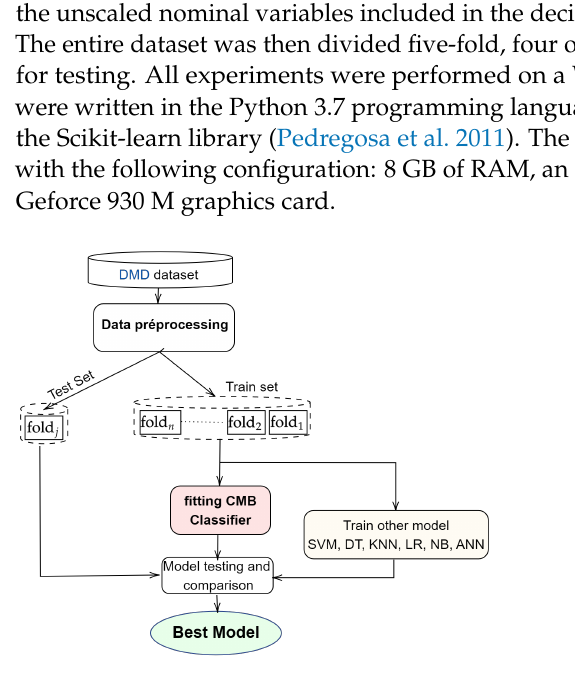
Figure 3. Illustration of our experimental